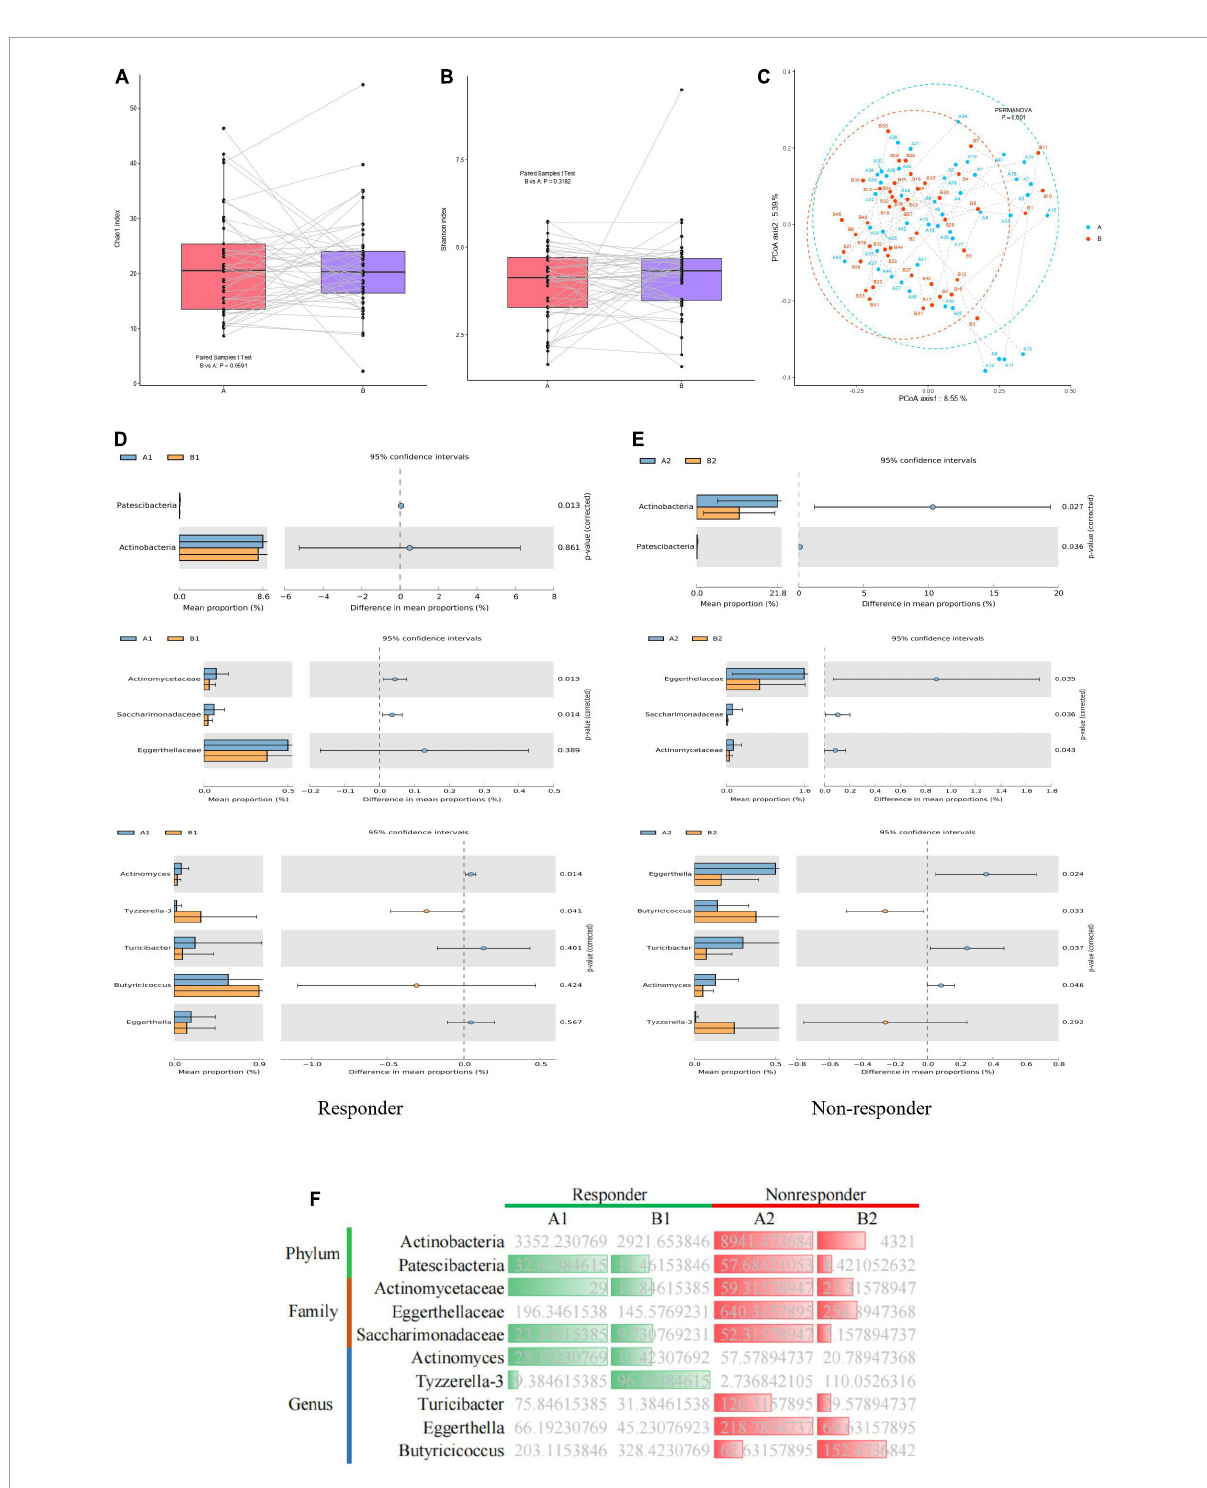
FIGURE4 Dynamic changes in gut microbiota of MDD patients before and after treatment. (A) Bacterial richness estimated using the Chao1 index. (B) Bacterial diversity estimated using the Shannon index. (C) β -diversity determined via PERMANOVA based on Bray–Curtis distances. Paired samples from the same individual before and after treatment are represented by dotted lines. (D,E) Significantly different species according to FDR-adjusted p -values, calculated using Welch’s t -test. The mean abundance in the blue (yellow) community differed before and after treatment. (F) Heatmap showing significantly different microflora before and after treatment in the responder and non-responder groups. Green indicates a significant difference in species abundance in the responder group before and after treatment. Red indicates a significant difference in species abundance in the non-responder group before and after